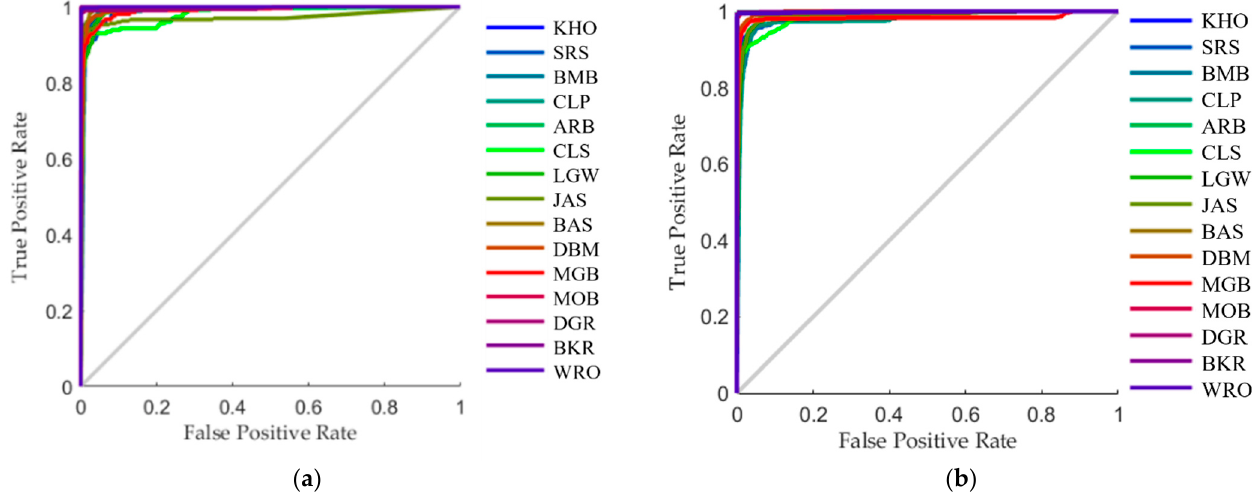
Figure 8. The receiver operating characteristic (ROC) curve of the artificial neural network models to classify 15 commercial rice samples using morpho-colorimetric parameters as inputs for ( a ) Model 1 and ( b ) Model 2. The abbreviations for rice samples are shown in Table 1.